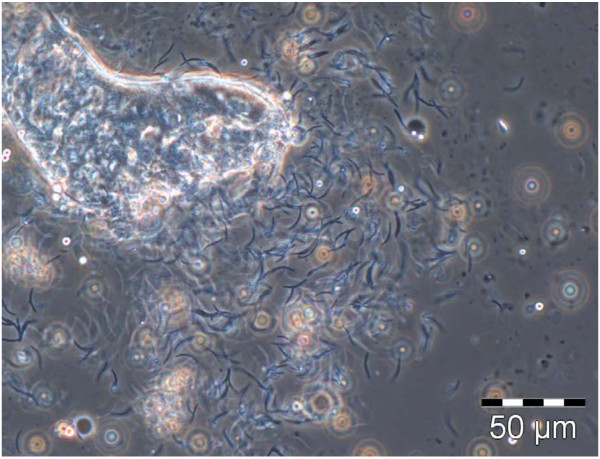
Ruptured An. funestus salivary gland showing mature crescent sporozoites of P. berghei (phase contrast, 400 × magnification).